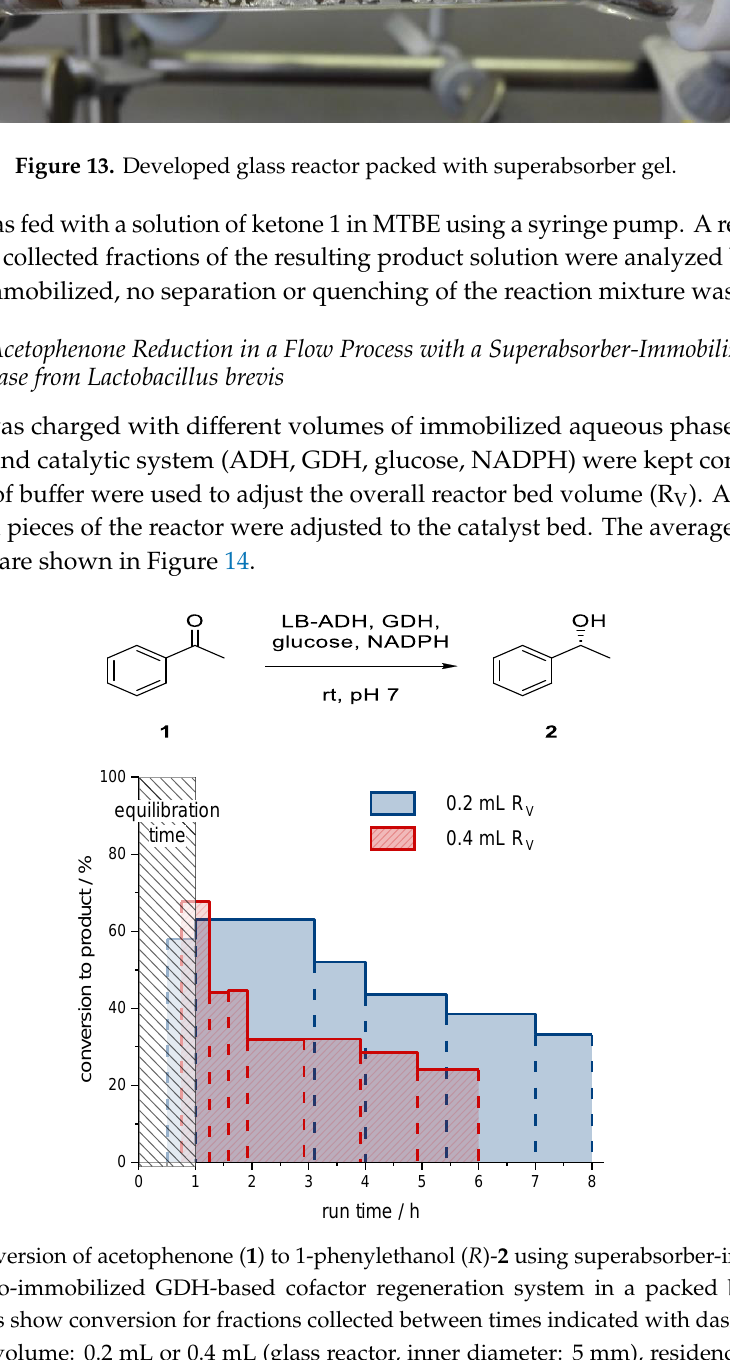
Figure 13. Developed glass reactor packed with superabsorber gel.